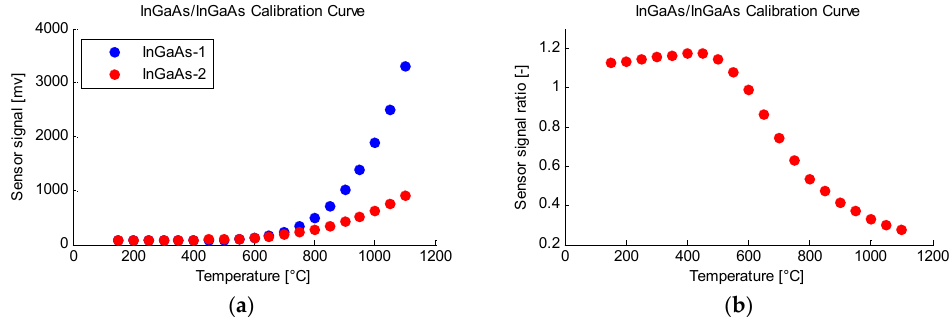
Figure 2. Experimental calibration points for the pyrometer presented in this work. ( a ) Represents the signal on each of the cells during the temperature rise. ( b ) Is the calibration curve obtained by dividing the values in both sensors.